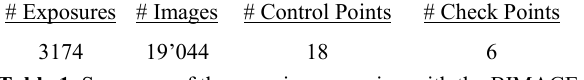
Table 1. Summary of the mapping campaign with the BIMAGE Backpack